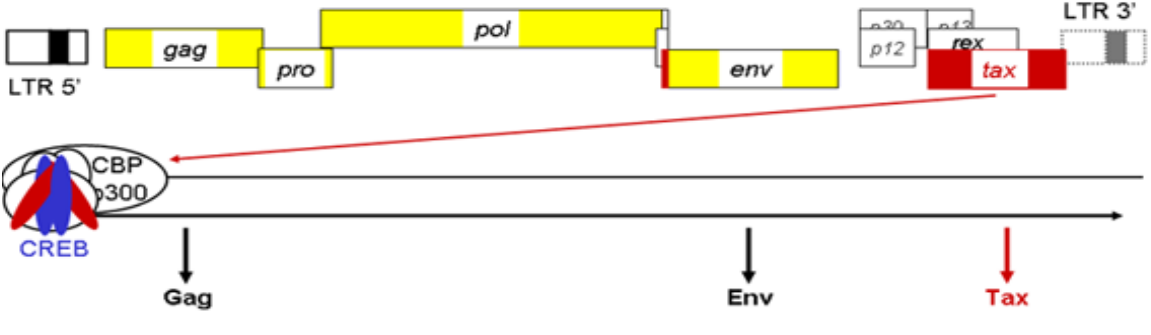
Figure 1. Schematic representation of the Human T-cell Leukemia Virus type 1 (HTLV-1) proviral genome. In addition to the common retroviral genes (in yellow), the provirus contains genes encoding different regulatory proteins. Among them, the Tax protein (in red) interacts with CREB (in blue) to bind to the Tax-responsive elements (TxREs). Tax then stabilizes the TxRE-bound complex and recruits p300/CBP to stimulate the viral transcription and the production of the different viral proteins such as Gag, Env, and